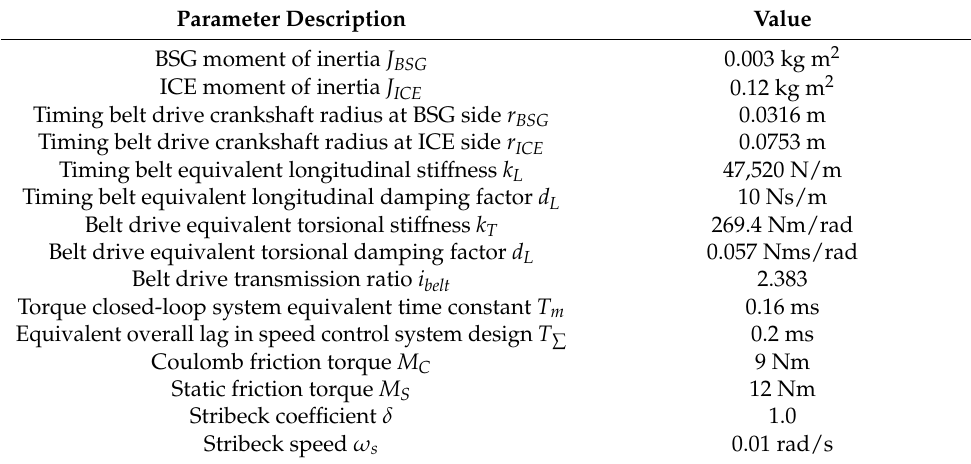
Table 1. Servo-controlled timing belt drive model parameters.